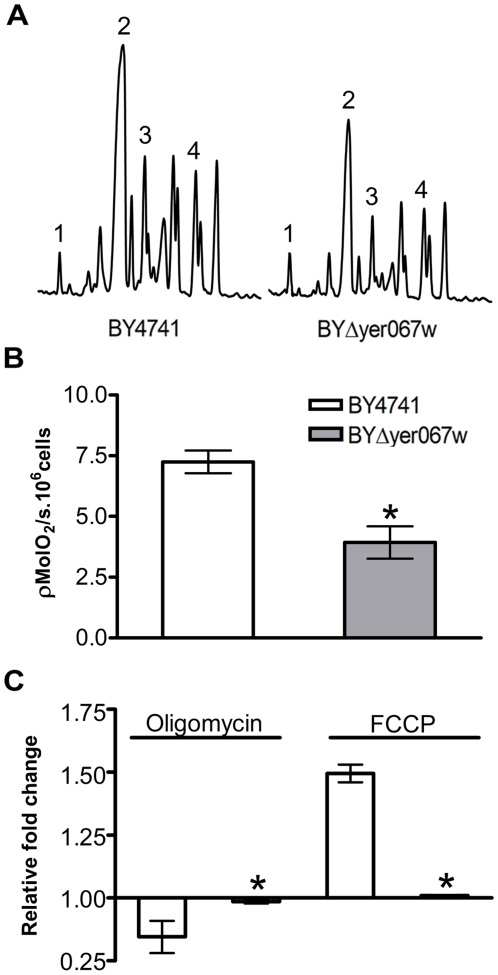
Analysis of the sterol composition and oxygen consumption of yeast cells deleted for YER067W gene.(A) The accumulation profile of GC sterols for BY4741 and BYΔyer067w. Peak 1, cholesterol (exogenous standard); peak 2, ergosterol; peak 3, fecosterol; and peak 4, lanosterol. Note that BYΔyer067w shows a reduced content of ergosterol (46%±5.0% four idependent extractions) indicating a down regulation in ergosterol synthetic pathway (B) Oxygen consumption rates of yeast cells growing in glycerol reveal an impaired respiratory metabolism in BYΔyer067w. (C) Relative changes in oxygen consumption rate caused by sequential addition of 5 µg/mL of oligomycin and 1 µM of FCCP. BYΔyer067w insensitivity to the drugs tested suggests that mitochondrial physiology is affected by the absence of YER067W protein. Asterisks indicate a significant difference from BY4741 (P<0.05 T-test).